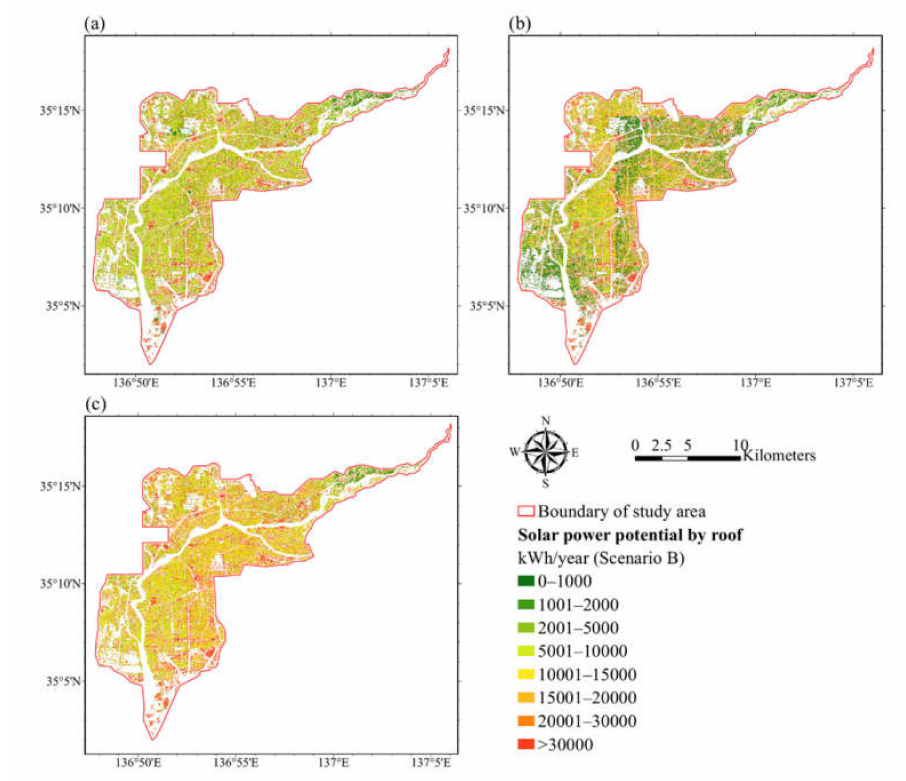
Figure 9. The electricity generation potential of solar photovoltaic (PV) estimated by three methods in western Aichi (Scenario B): ( a ) Method 1 ( b ) Method 2 ( c ) Method